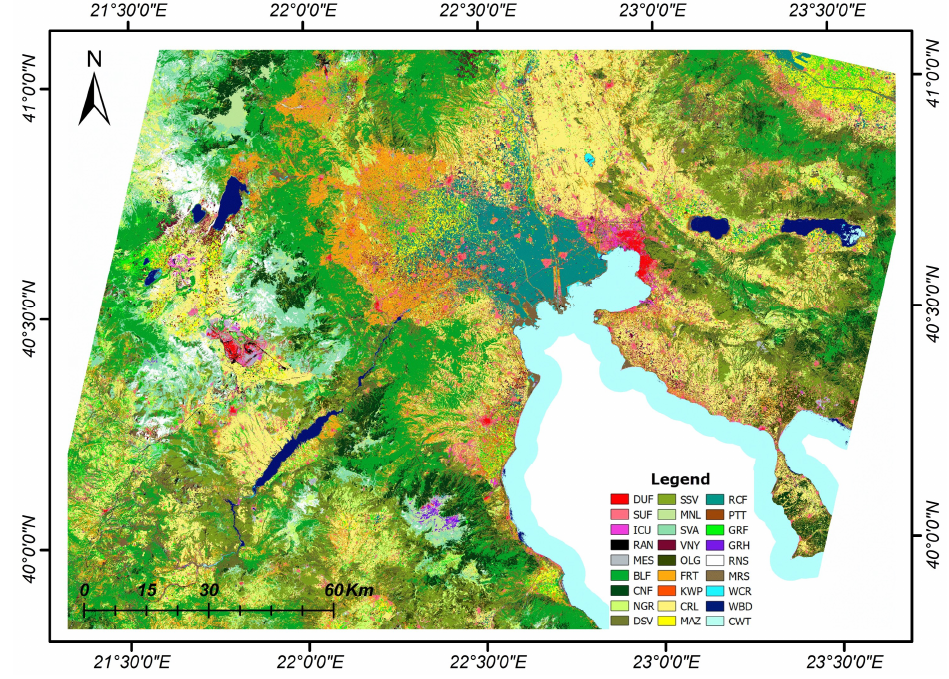
Figure 8. The classified map of the study area using 14 images/dates of cloud cover up to 30% after feature selection on 70% of top-ranked features for the 27 land cover classes with an OA of